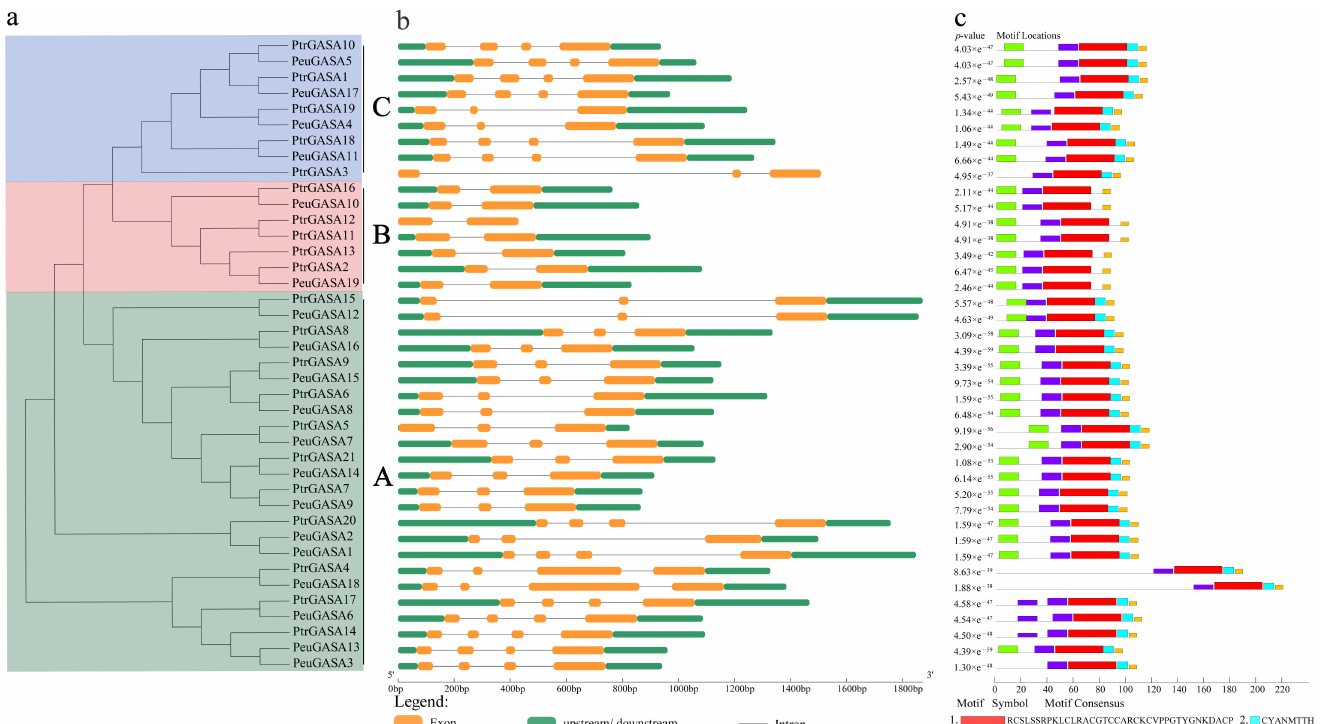
Figure 4. Gene structures and motif analysis of GASA gene family in P. euphratica and P. trichocarpa . ( a ) Phylogenetic tree of PtrGASAs and PeuGASAs. Subfamily A/B/C were represented by green, red and blue respectively; ( b ) Gene structures of PtrGASA s and PeuGASA s. Upstream or downstream non-coding regions were represented by green rounded rectangles, exons by orange rounded rectangles, and introns by gray lines; ( c ) Conserved motifs of PtrGASAs and PeuGASAs. Conservative motifs were presented in different colored boxes. The length of each nucleotide sequence or protein sequence can be estimated using the scale below the